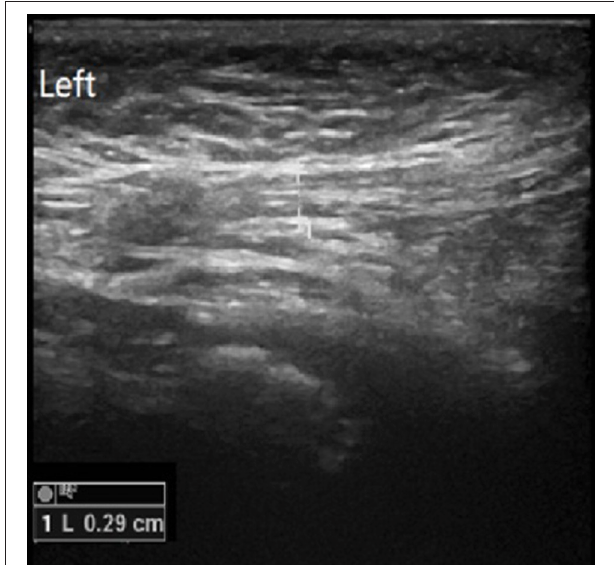
FIGURE 4 | Diameter of the normal side.